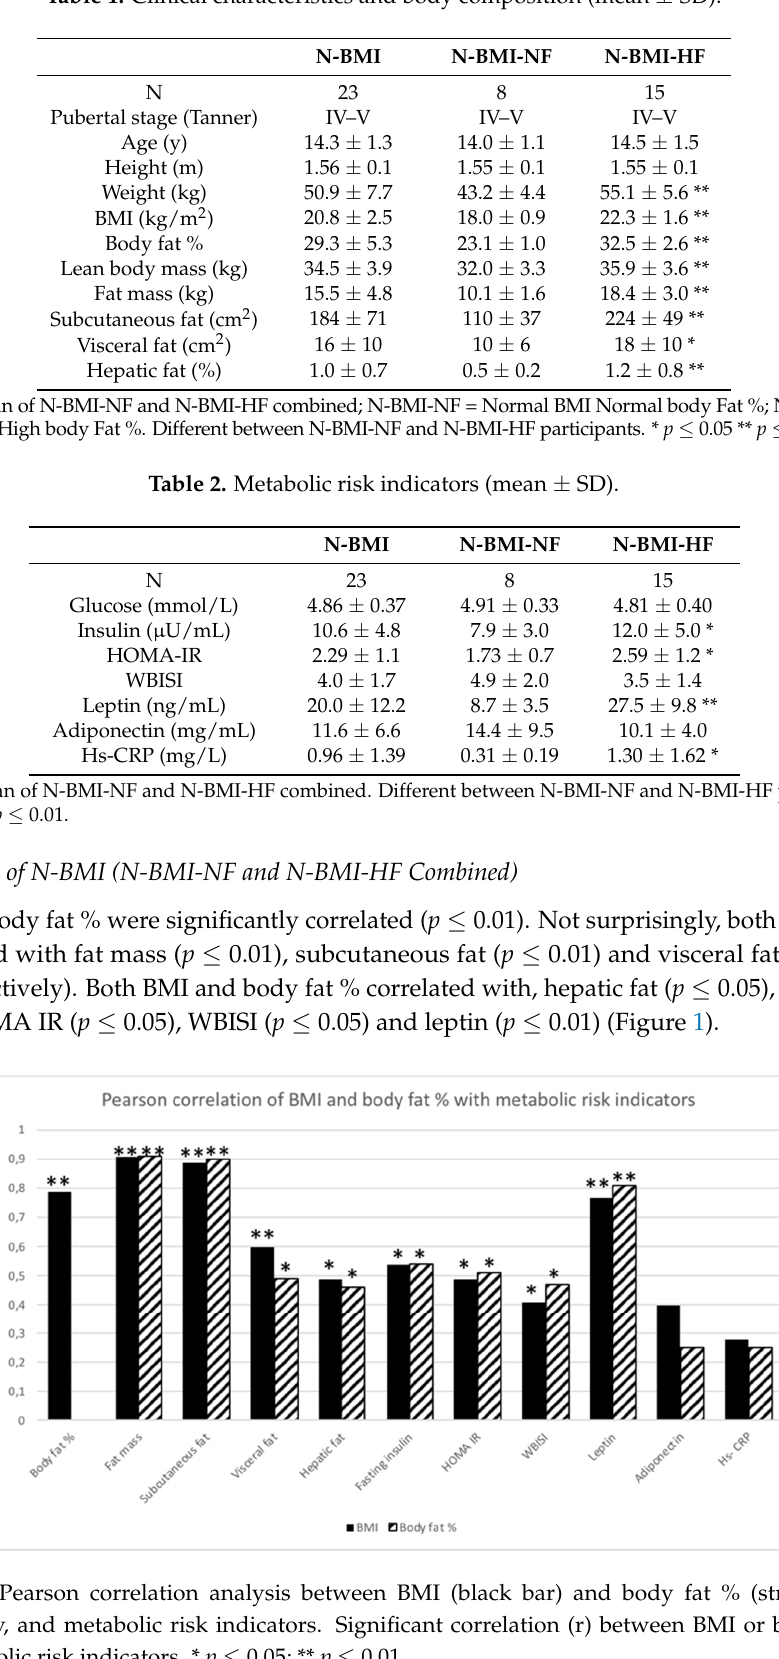
Table 1. Clinical characteristics and body composition (mean ± SD).